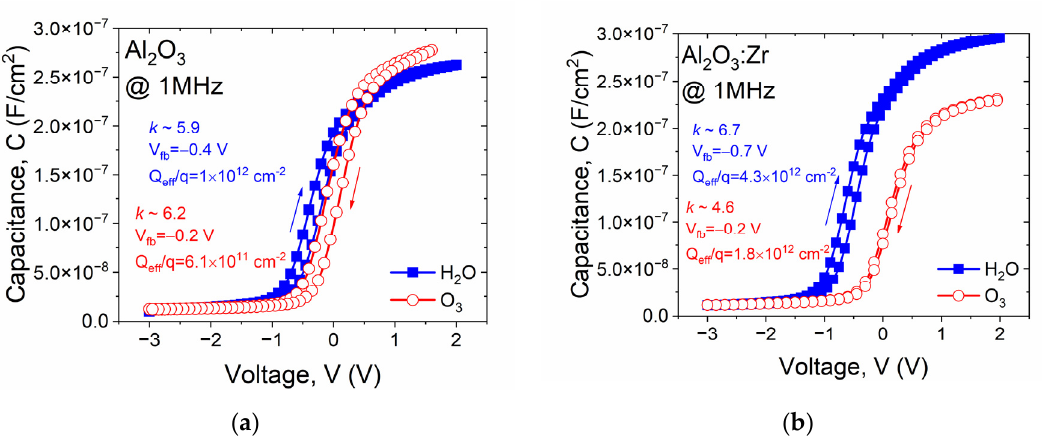
Figure 7. Comparison of the hysteresis loop of representative C-V characteristics (signal frequency, f = 1 MHz) of MIS structures with Al 2 O 3 -based gate dielectric layer: ( a ) Al 2 O 3 and ( b ) Al 2 O 3